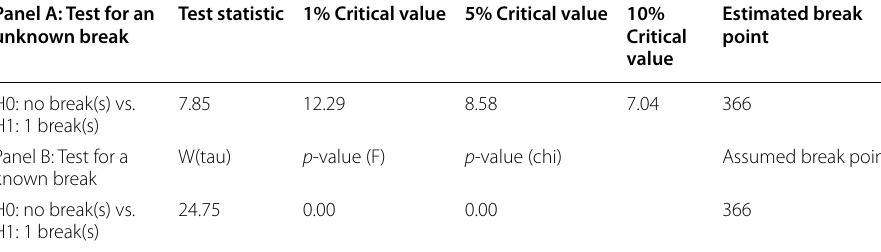
Table 8 Bai and Perron critical values for CCEI Panel A: Test for an unknown